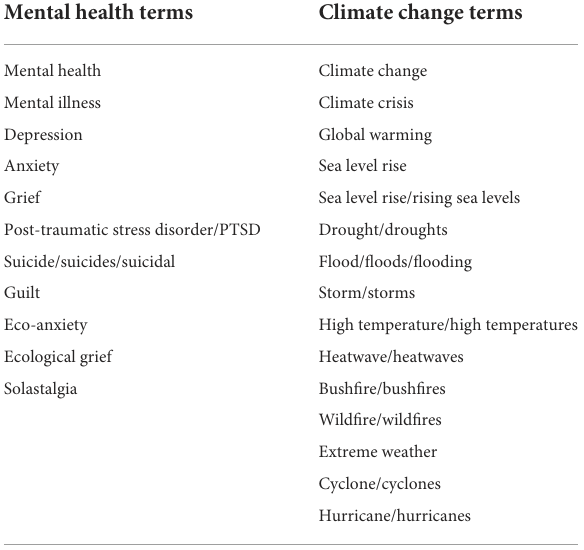
TABLE 1 Search terms used for querying the Hansard database, based on Met Office climate change-related events and literature on the links between climate and mental health.